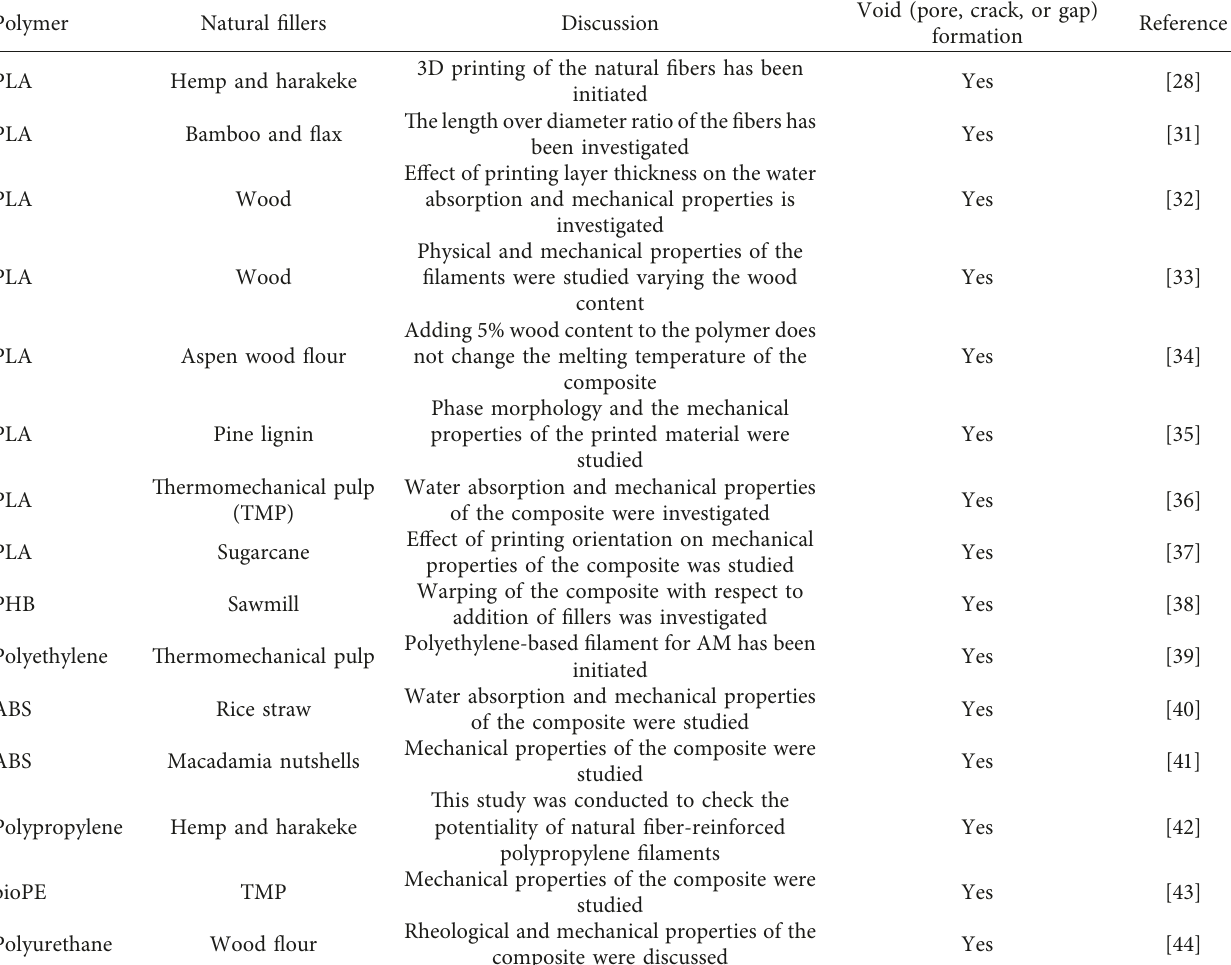
Table 3: Some of the research studies on 3D printing of the natural filler composites and its discussion.